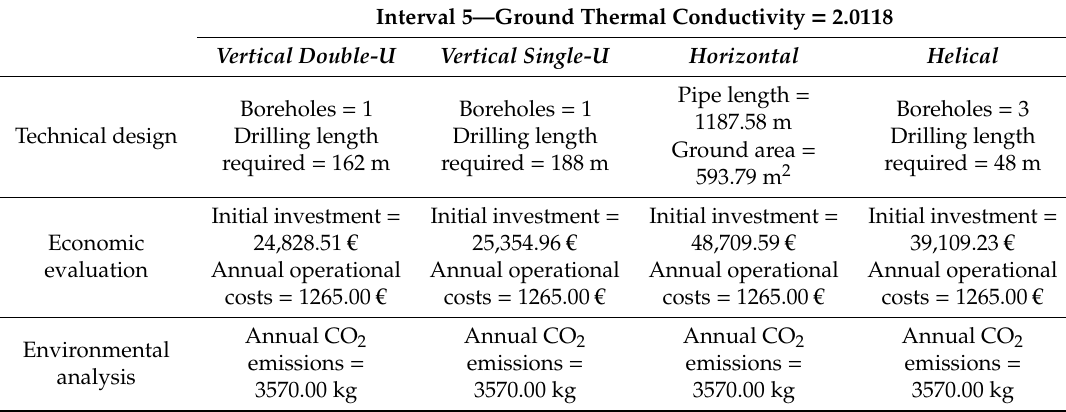
Table 9. Design provided by GES-CAL software for the geothermal system under study, interval